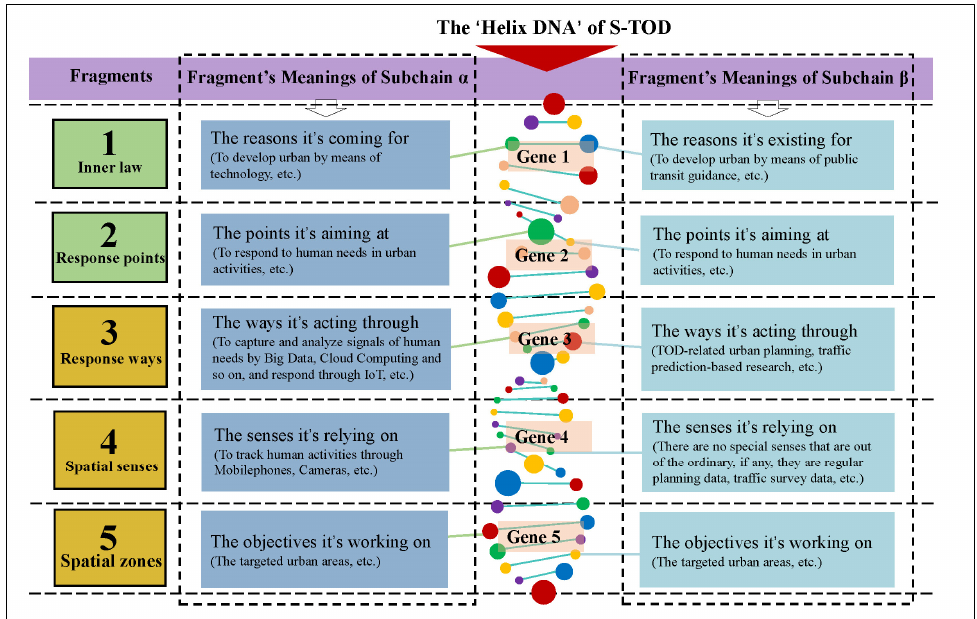
Figure 10. The construction logic of the DNA of S-TOD. We formed a helix DNA for S-TOD, through the integration of Subchain α and Sub- chain β and the combination of their characteristics. The five fragments of the subchains are transformed to be five critical genes of the DNA of S-TOD. Figure 11 illustrates the DNA map of S-TOD including Gene 1 (the inner law), Gene 2 (the response points), Gene